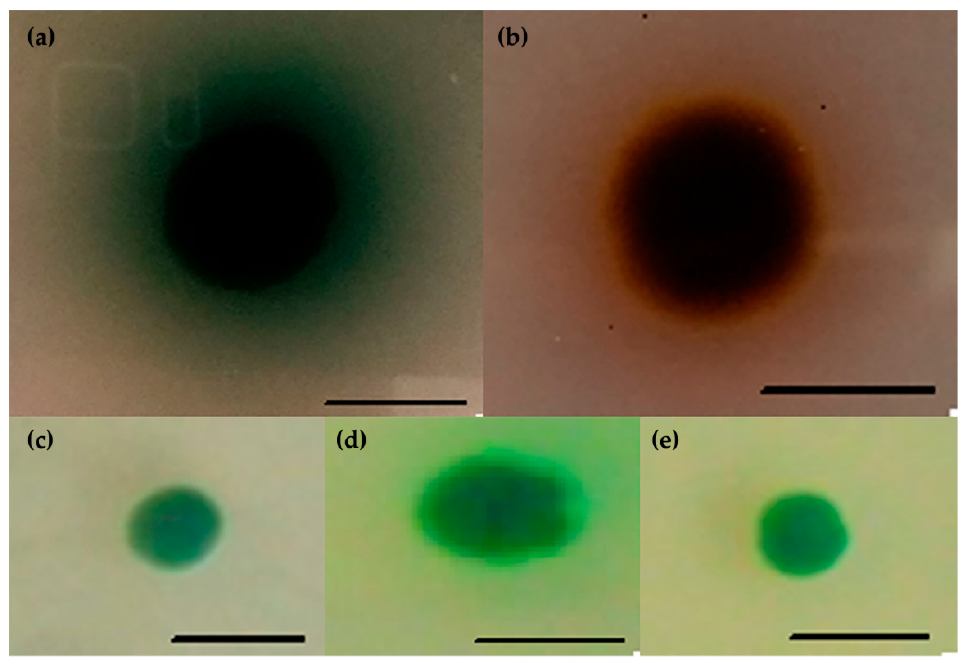
Figure 2. Screening for laccase synthesis. ( a ) Strain G3 IBMiP on medium with ABTS; ( b ) strain G3 IBMiP on medium with guaiacol; ( c ) Leuconeurospora sp. D59 IBMiP on medium with ABTS; ( d ) Cryptococcus gastricus DBVPG on medium with ABTS; ( e ) Cryptococcus aerius DBVPG on medium with ABTS. Black bars indicate the length of 10 mm.